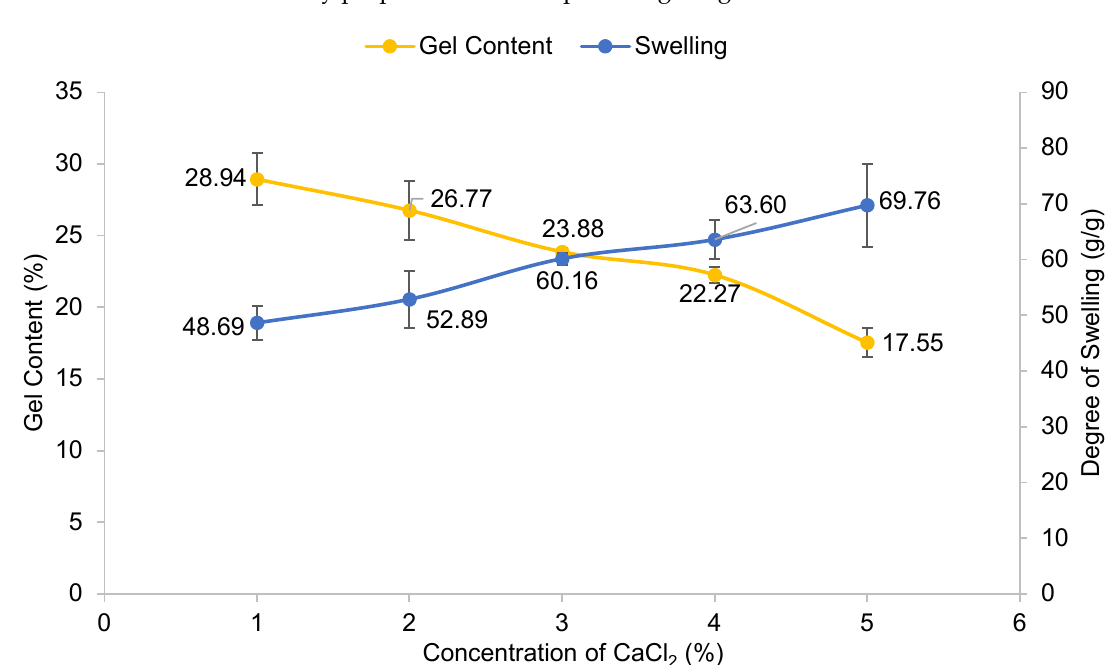
Figure 4. Effect of concentration of CaCl 2 on gel content and degree of swelling of CMC hydrogel. Error bar indicates the standard deviation of uncertainty.